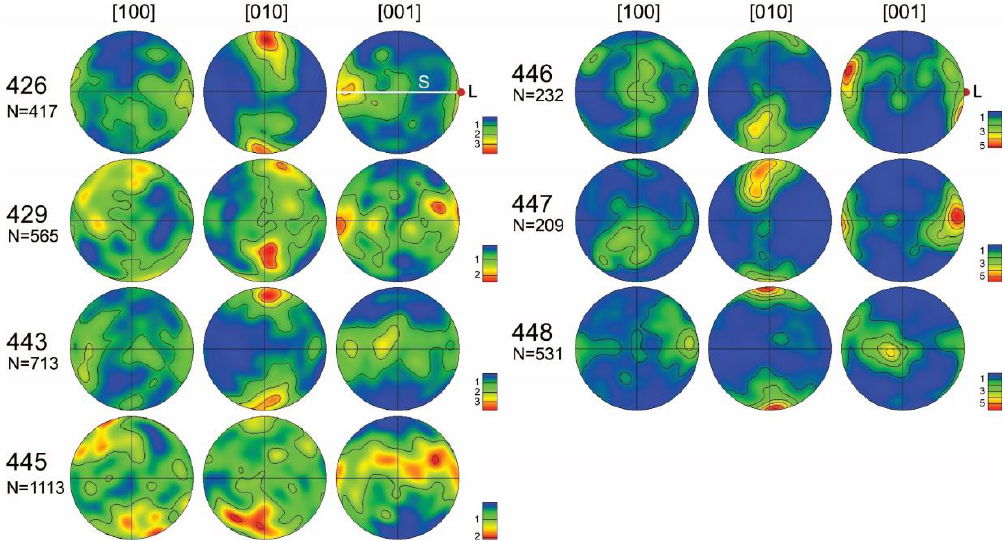
Figure 3. Pole figures of the olivine presented in the lower hemisphere using equal-area projection. The white line (S) represents foliation and the red dot (L) represents lineation. A half-scatter width of 20° was used. “N” represents the number of grains. The color-coding indicates the density of the data points. The numbers in the legend correspond to multiples of uniform distribution.